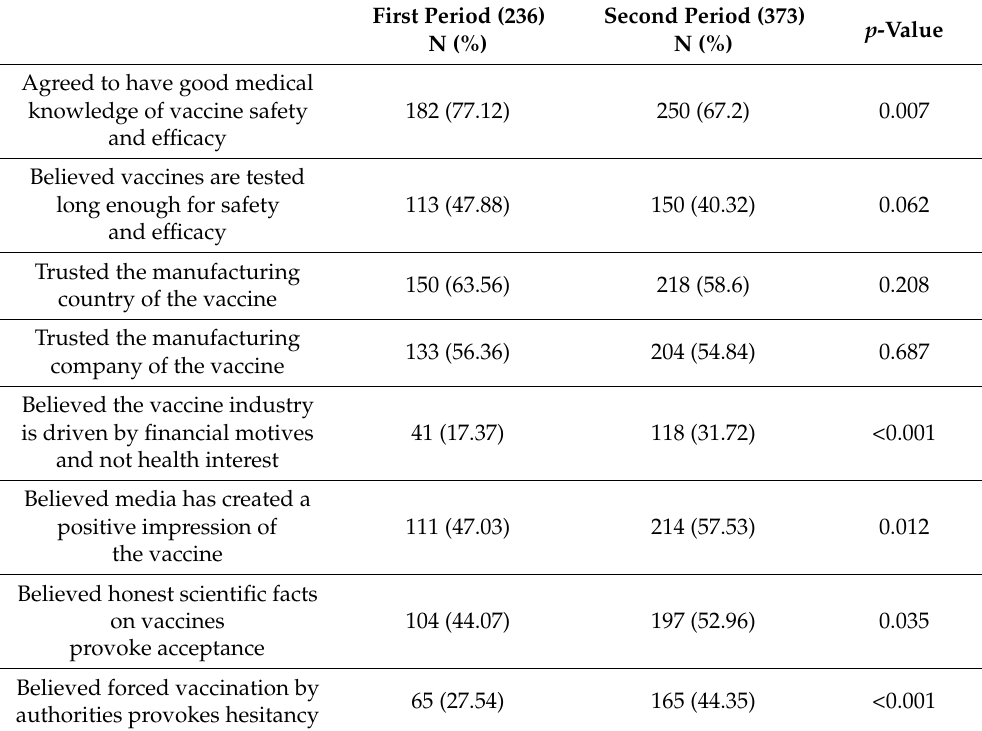
Table 2. Thoughts and beliefs of HCPs regarding COVID-19